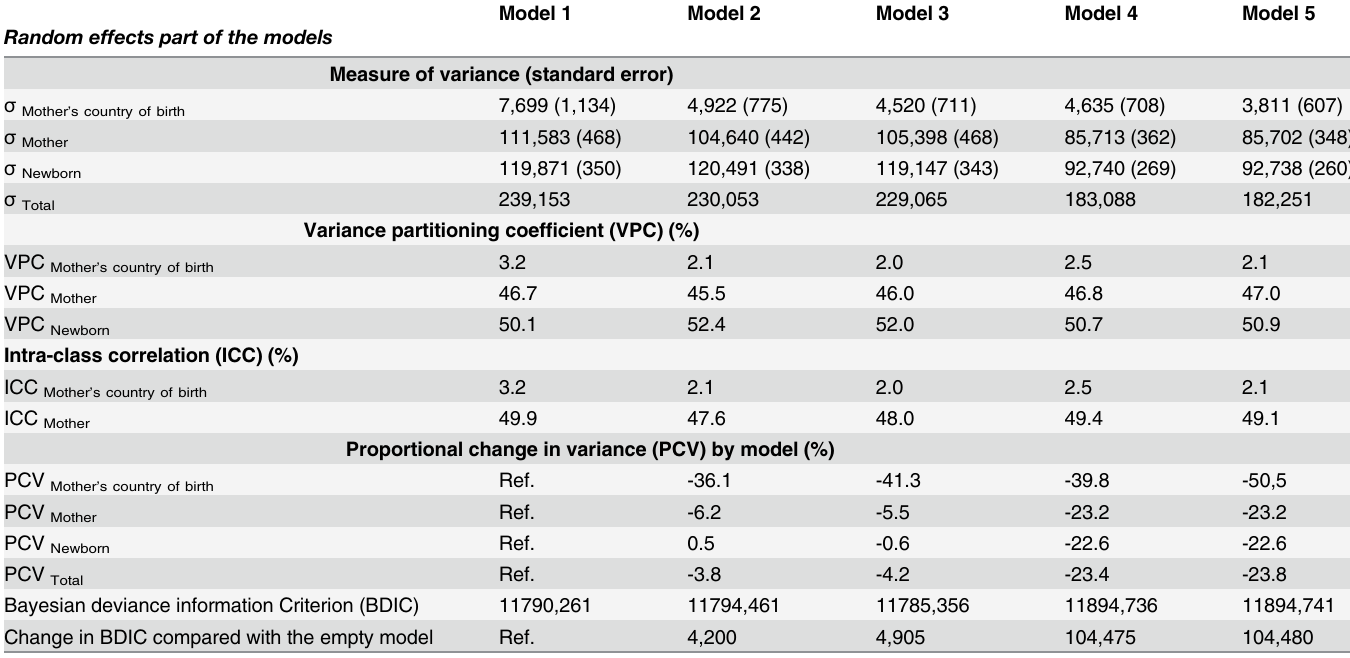
Table 3. Multilevel linear regression analysis of babies, mothers and maternal countries of birth, modelling birthweight (in grams) 1